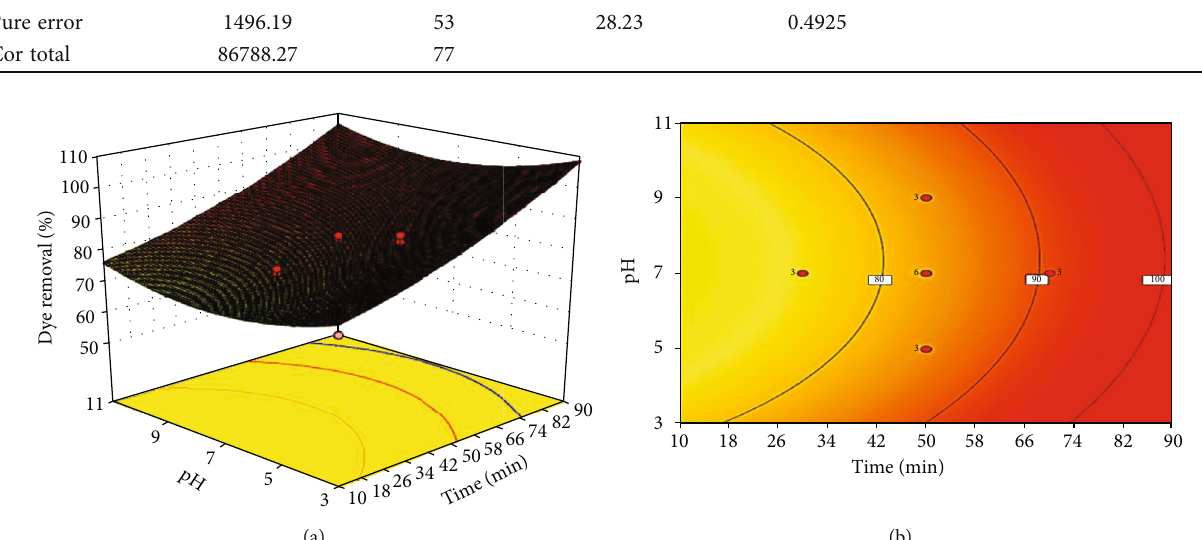
Figure 4: 3D response surface and 2D contour plots show the e ff ect of pH and contact time on the RR2